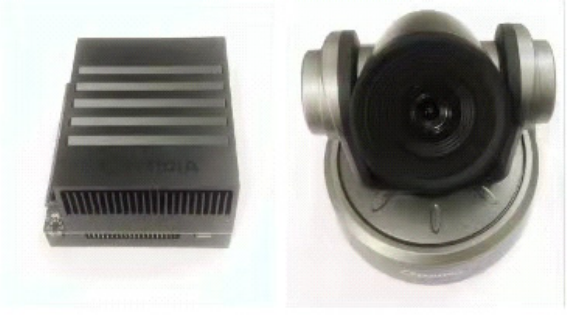
Figure 6. Test Figure 6. Test platform. Figure 6. Test platform.